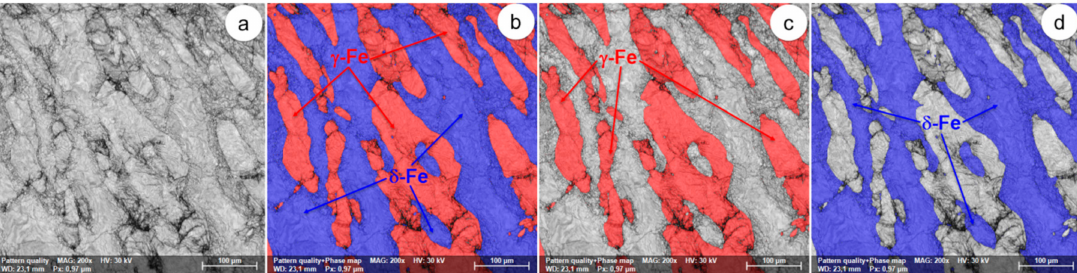
Figure 16. The SEM-EBSD composite images ( × 200) obtained after forging at 1100 ◦